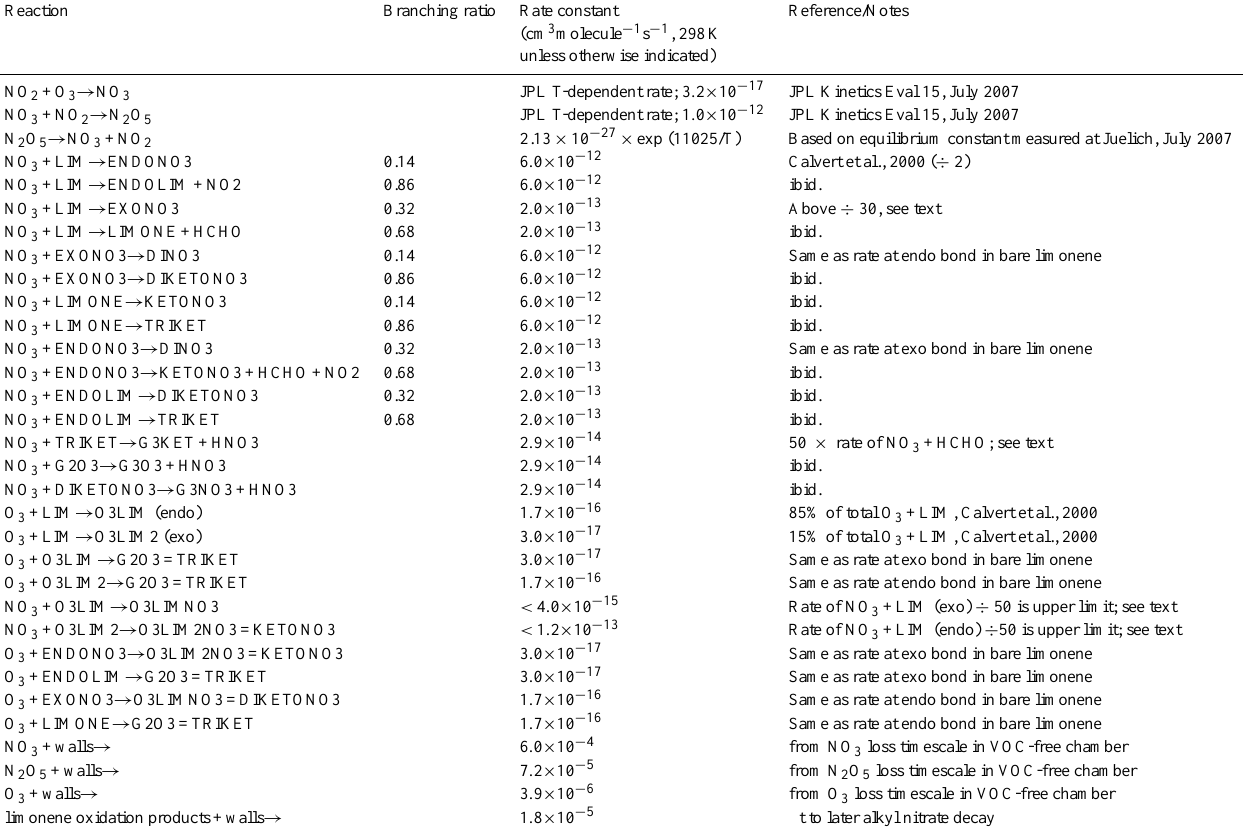
Table 2. Reaction rate constants and branching ratios used in gas-phase portion of kinetics box model. For structures corresponding to variable names, see reaction scheme